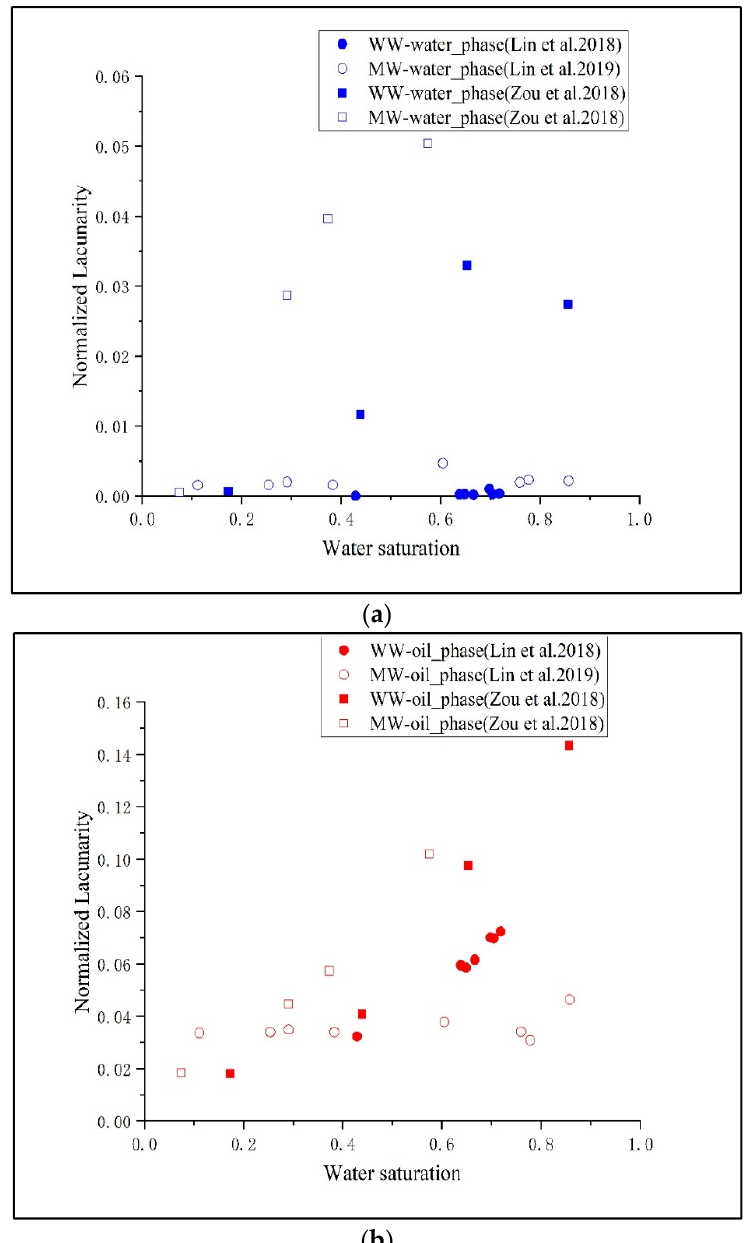
Figure 4. Comparison of the normalized lacunarity results for water phase ( a ) and oil phase ( b ) in water-wet and mixed-wet cases.